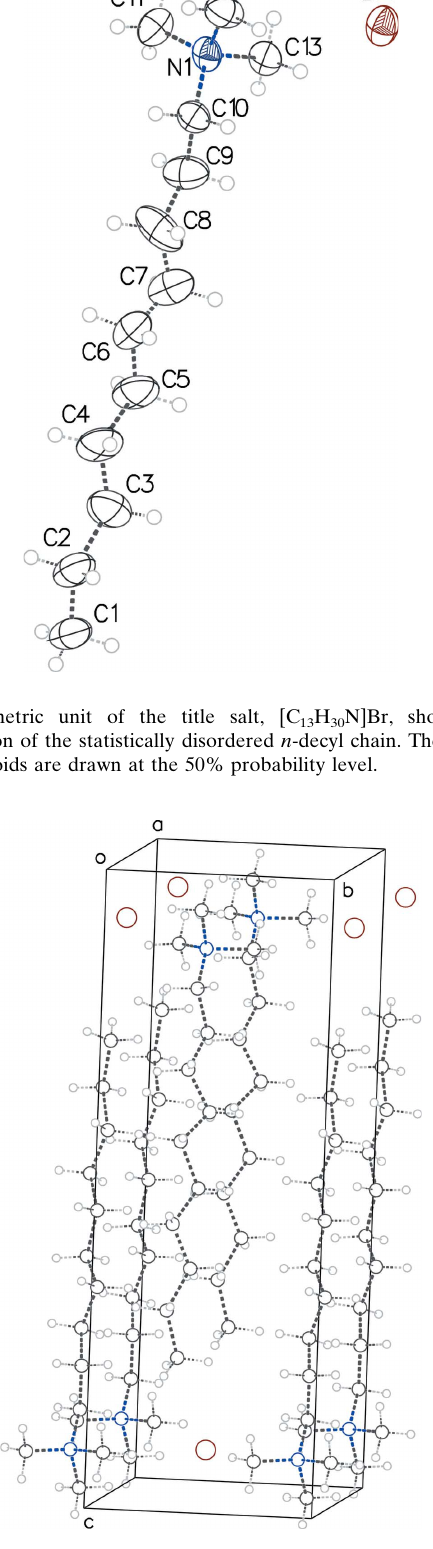
Table 1 Hydrogen-bond geometry (A˚ , (cid:4) ).